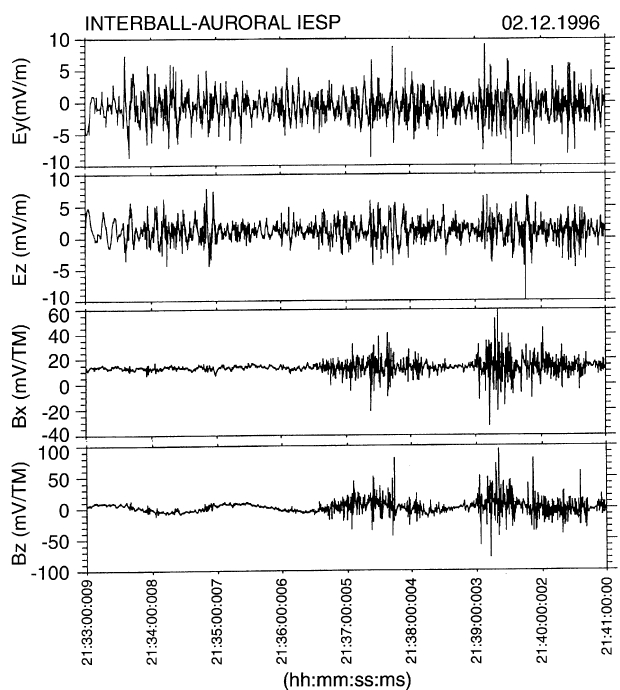
Fig. 6. Same as Fig. 1 for the event displayed in Plate 3. Notice that during this time-interval the magnetic components vary in intensity whereas the electric ones do not